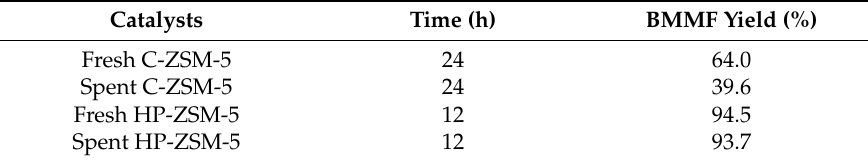
Table 2. Reusability of the C-ZSM-5 and HP-ZSM-5 in the etherification of BHMF a . Catalysts Time (h)